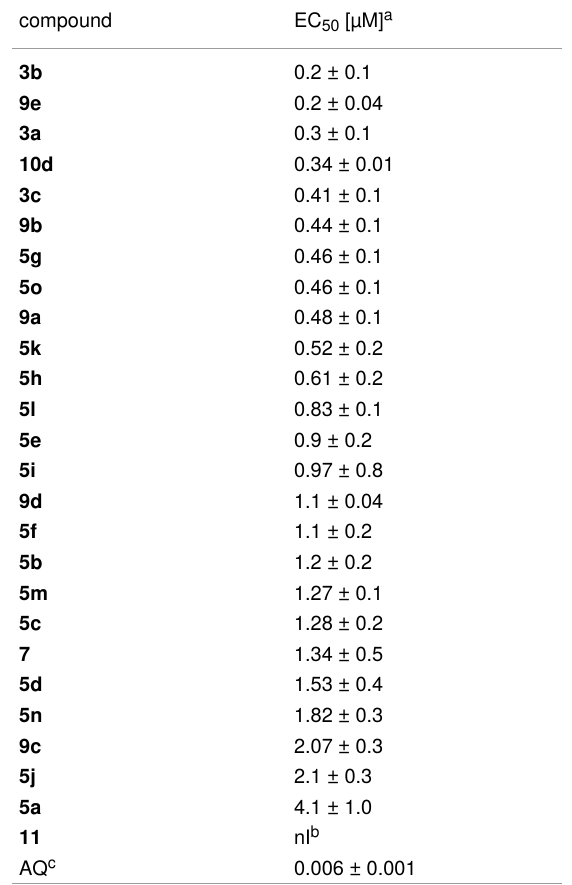
Table 1: EC 50 values of newly synthesized inhibitors on P. falciparum